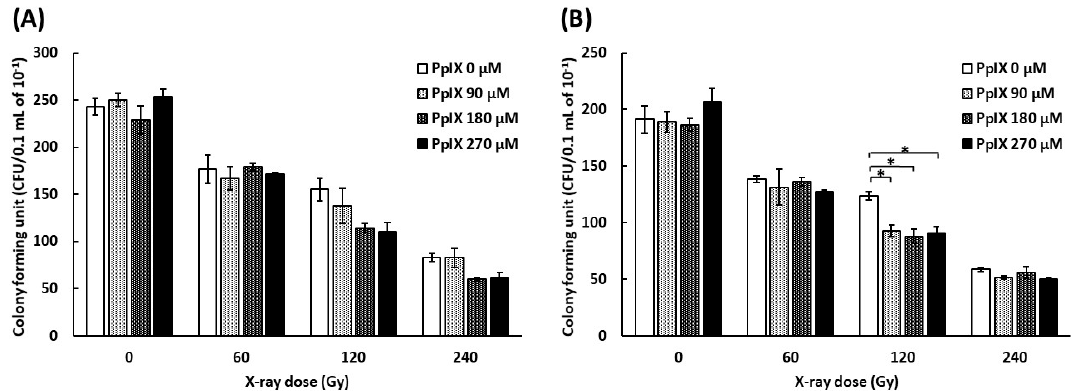
Figure 4. Evaluation of the functional decline of DNA by X-ray irradiation and enhancement by PpIX for plasmid pBR322. (A) The number of E. coli colony forming units (CFUs) on medium with ampicillin by transforming plasmid irradiated with X-ray at different concentrations of PpIX. (B) The number of E. coli colony forming units (CFUs) on medium with tetracycline. (Data given with n = 3, *: p < 0.05 in a one-way ANOVA and Tukey post-test)